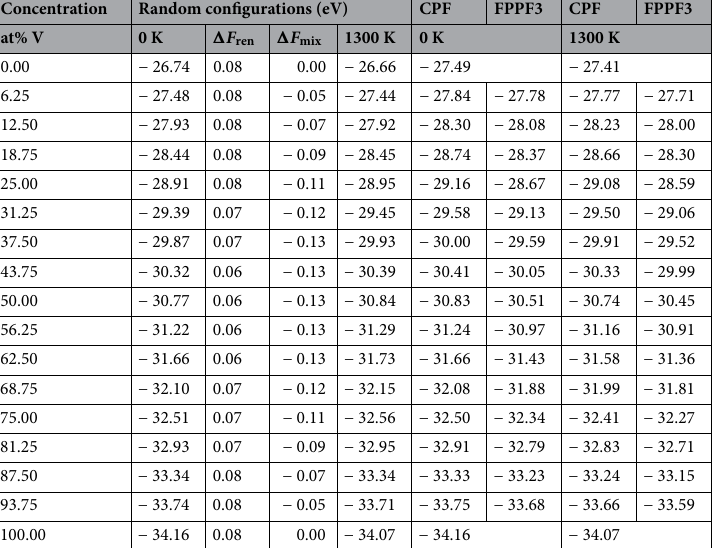
Table 3. Total free energy per four atoms of each composition in units of eV. For the purely random configurations, the energy at 0 K, the potential renormalization correction (cid:31) F ren , the mixing entropy TS mix , and the free energy at 1300 K are listed in the second to fifth columns. For the results of the (cid:31) F mix = − CPF and FPPF3 simulations, the energy at 0 K and the free energy at 1300 K are listed in the last four columns.